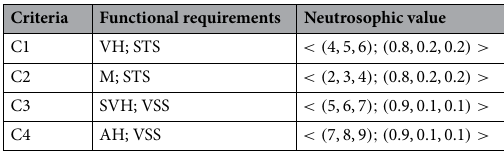
Table 2. FRs for CT modality.